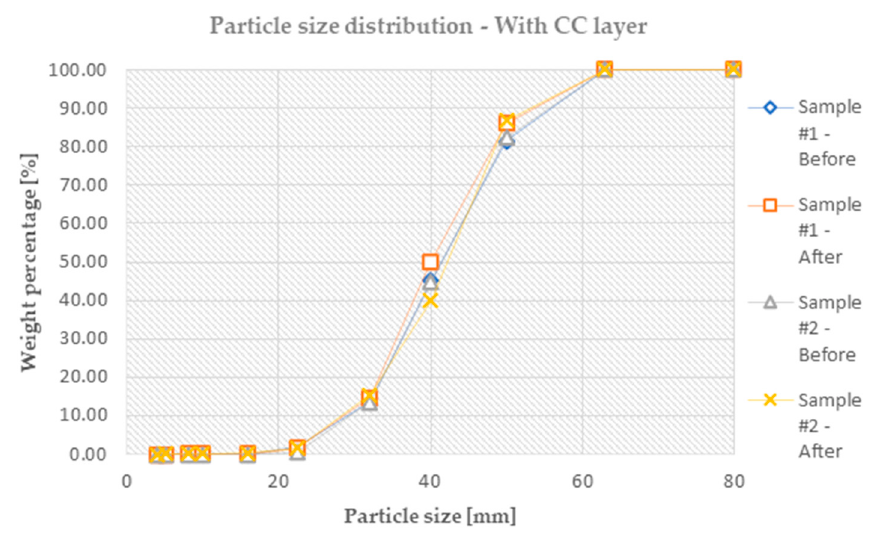
Figure 8. The particle size distribution before and after the tests for the specimens with CC layer (PSD—particle size distribution).